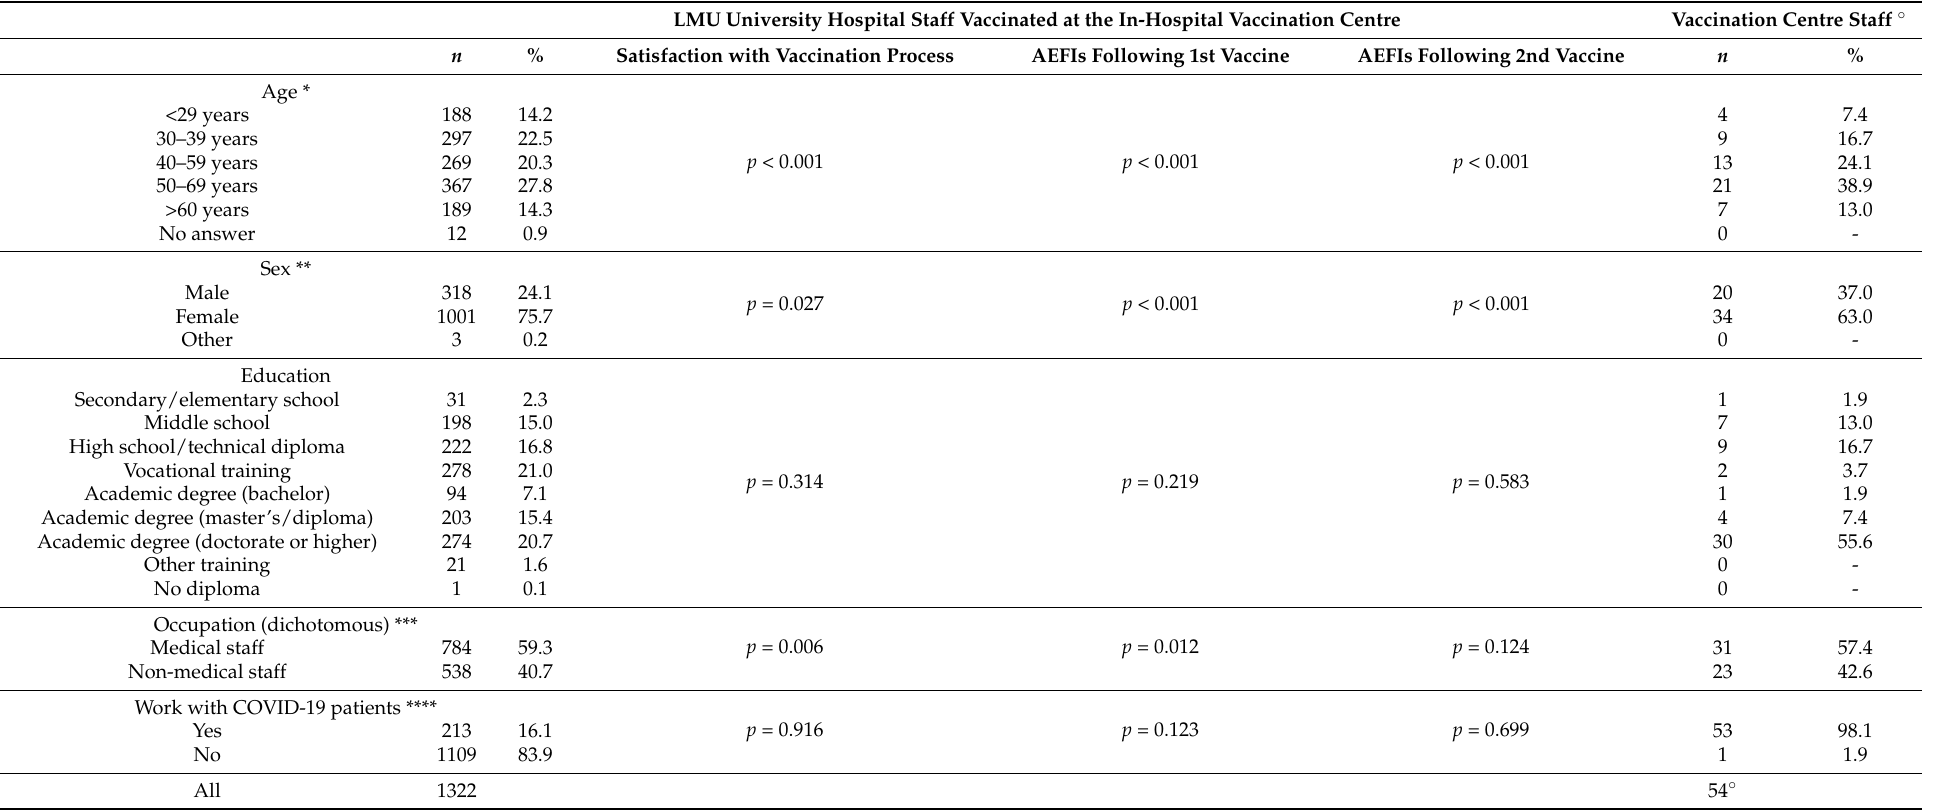
Table 1. Sociodemographic and occupational data of surveyed HCWs vaccinated at the in-hospital centre as well as of surveyed vaccination centre staff. Potential factors were tested for association with satisfaction with a chi-square test. LMU University Hospital Staff Vaccinated at the In-Hospital Vaccination Centre Vaccination Centre Staff ◦